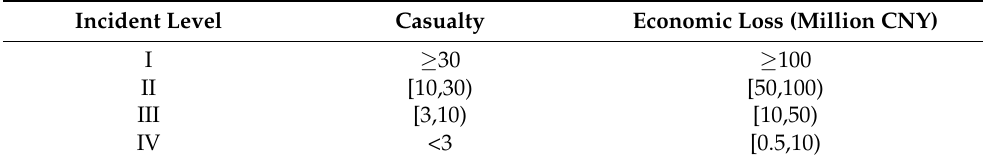
Table 3. The levels and criteria for dangerous chemical accidents in